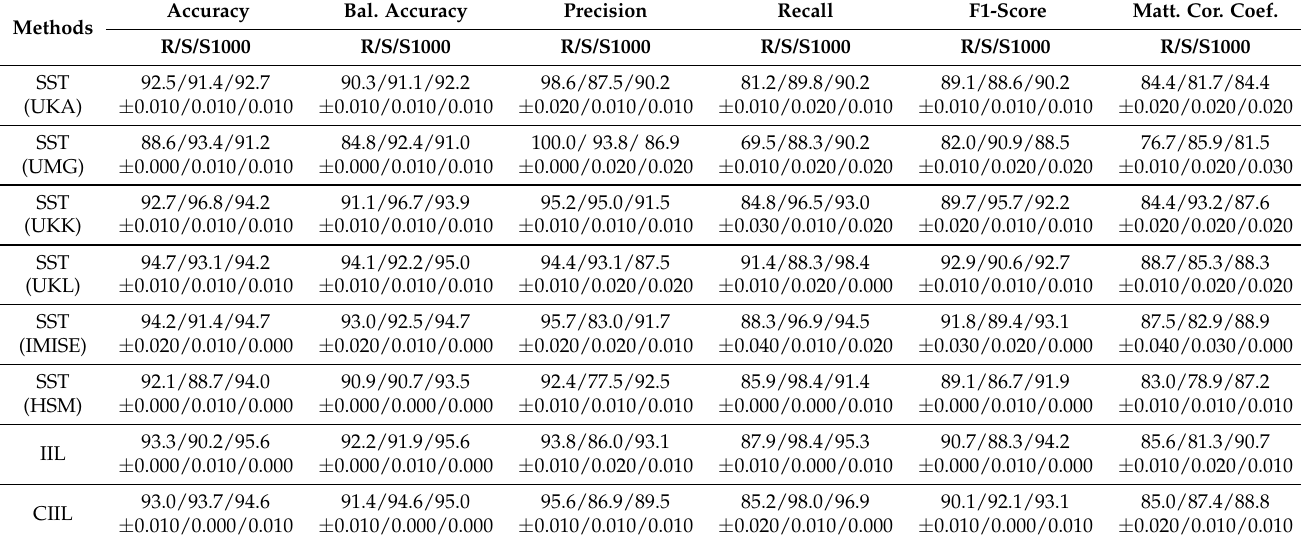
Table 4. Results in non-IID setting (unequally-sized and unbalanced class distribution). The meaning of the abbreviations are: real-world data (R), synthetic data (S) and synthetic data with the generation size of 1000